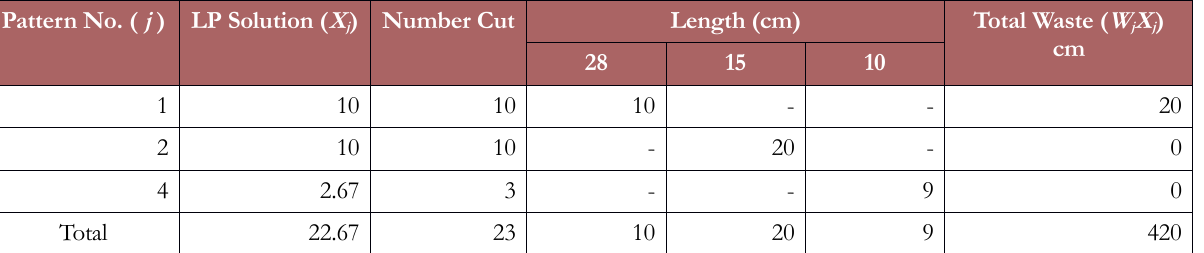
Table 12. Solution to Case II Product II (Panel